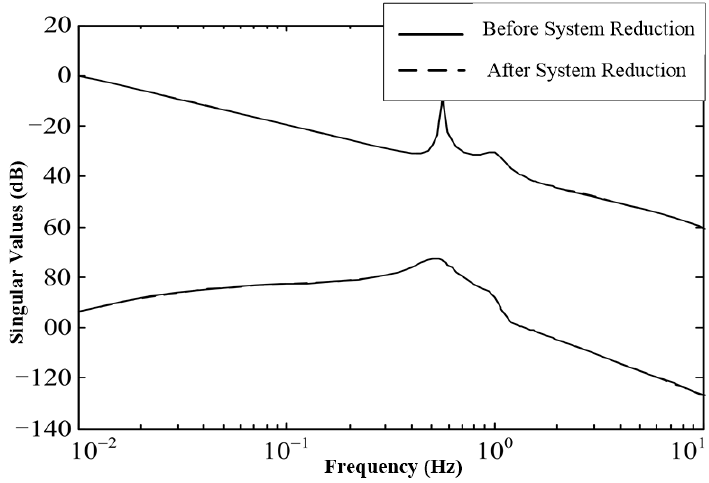
Figure 9. Comparison of Singular Values Before and After System Reduction.